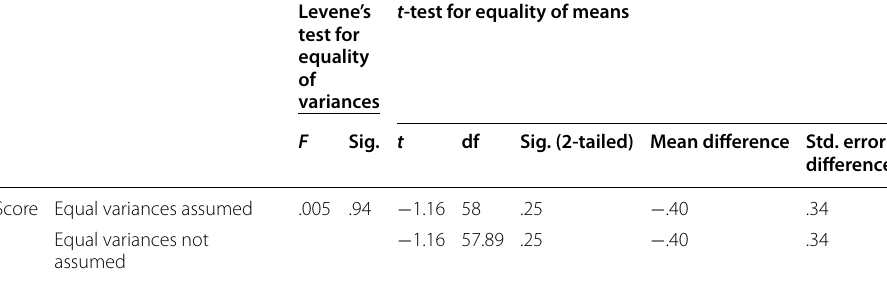
Table 7 Inferential statistics (fluency pre‑test of both groups)